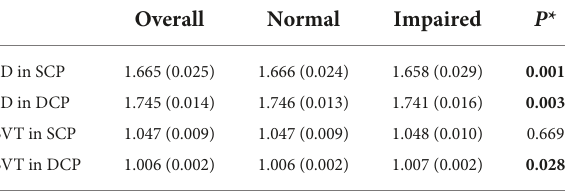
TABLE 2 Fractal dimension and tortuosity in participants stratified by estimated glomerular filtration rate. Overall